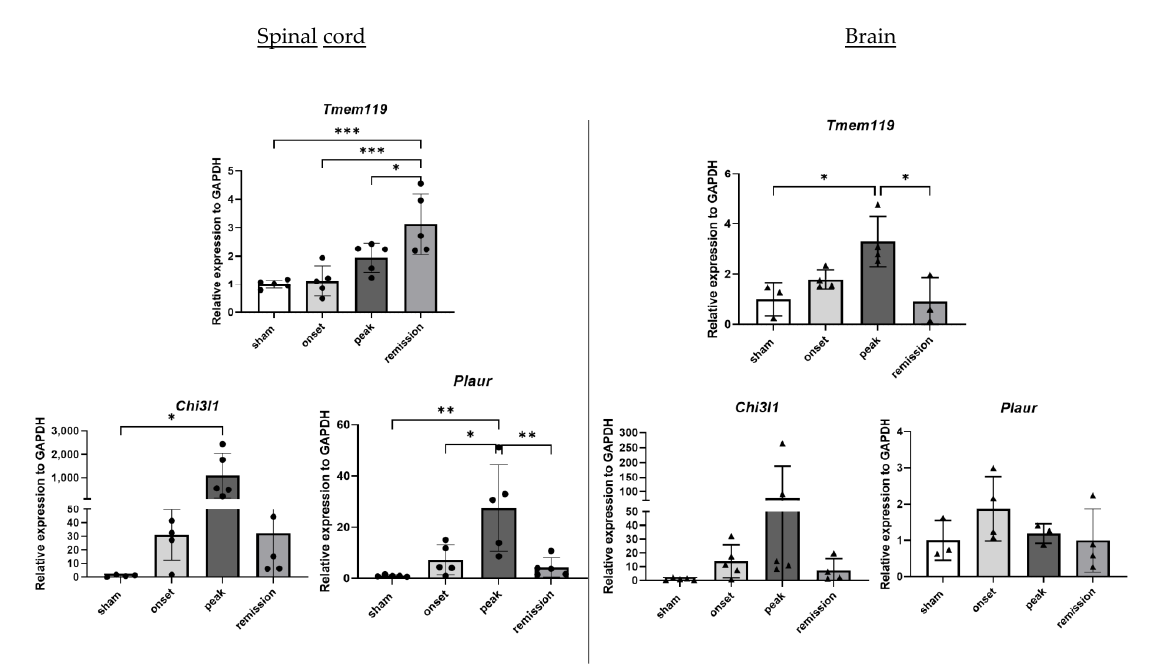
Figure 6. Differential expression of genes representative of microglial activation in CNS organs during the different phases of PLP-induced EAE. The levels of mRNA transcripts for the selected genes relative to Gapdh were measured in the spinal cord ( left ) and brain ( right ) samples isolated from adjuvant controls and EAE mice on the onset, peak, and remission phases by RT-qPCR. A number of 3 to 5 mice was used in the experiment. Each symbol represents a sample. * p < 0.05, ** p < 0.01, *** p < 0.001, one-way ANOVA.